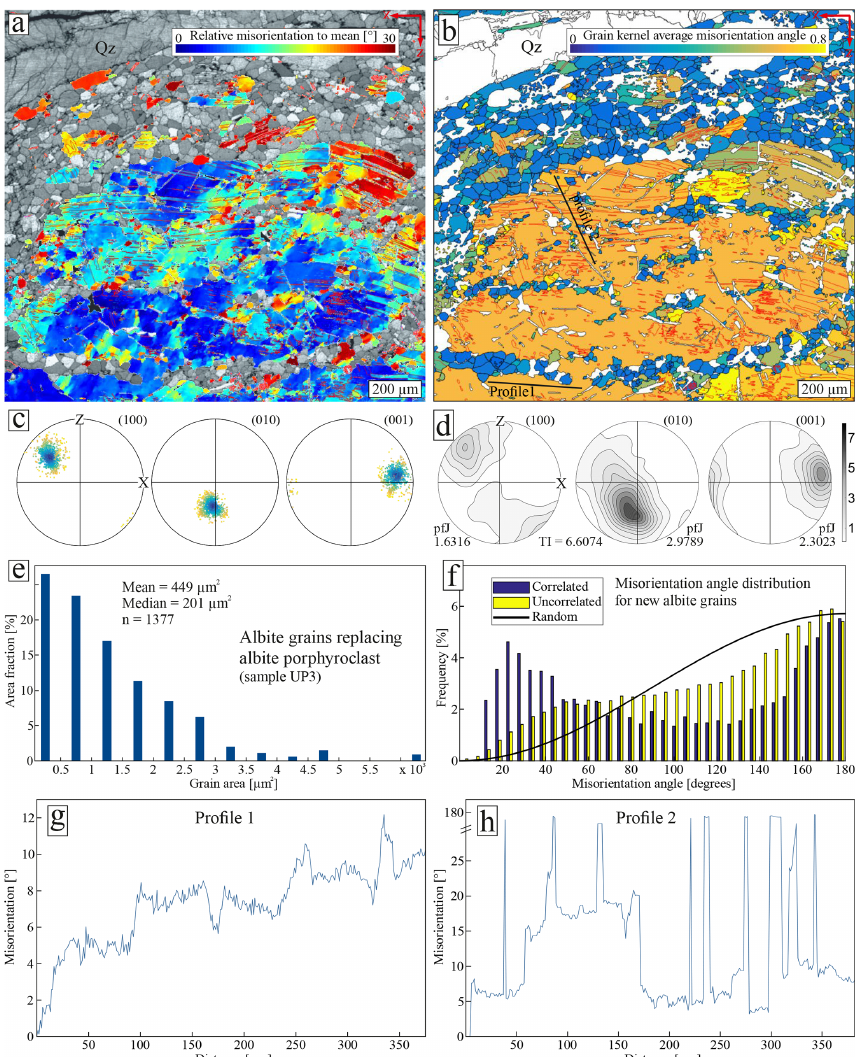
Figure 8. (a, b) EBSD-relative misorientation map for albite relative to the mean orientation of the porphyroclast (a) and gKAM map, showing a lower inferred dislocation density for new grains (b) of the area in the violet box in Fig. 7b. Red lines indicate albite and pericline twin boundaries. (c, d) Corresponding pole figures colour coded corresponding to the EBSD-relative misorientation map (c) and scatter plot (colour coded corresponding to a ), where only grains smaller than 100µm and free of visible twins were used. (e) Grain area distribution for new grains smaller than 100µm. (f) Misorientation angle distribution for adjacent and random pairs of new albite grains. (g, h) Misorientation profiles (relative to origin) along lines shown in panel (b)